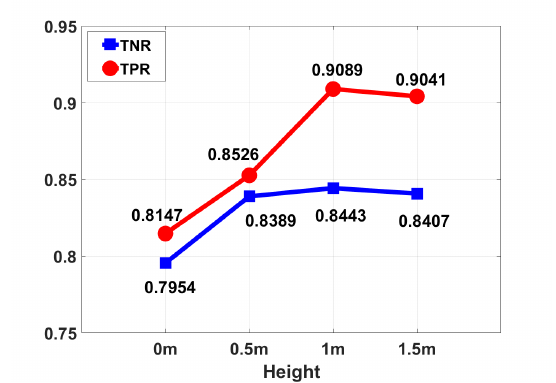
Figure 16. Performance results under different heights of TX and RX.